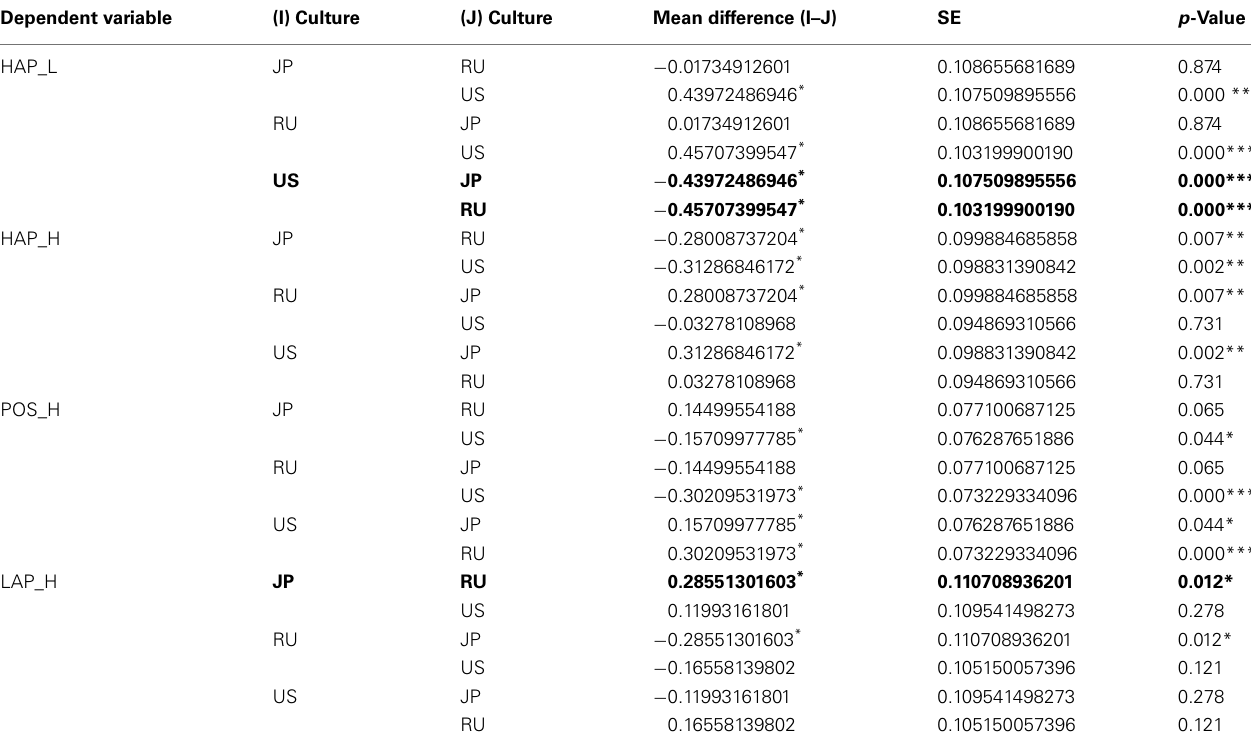
TableA5 | Post hoc comparisons of ipsatized scores were conducted following the logic outlined in the main paper.